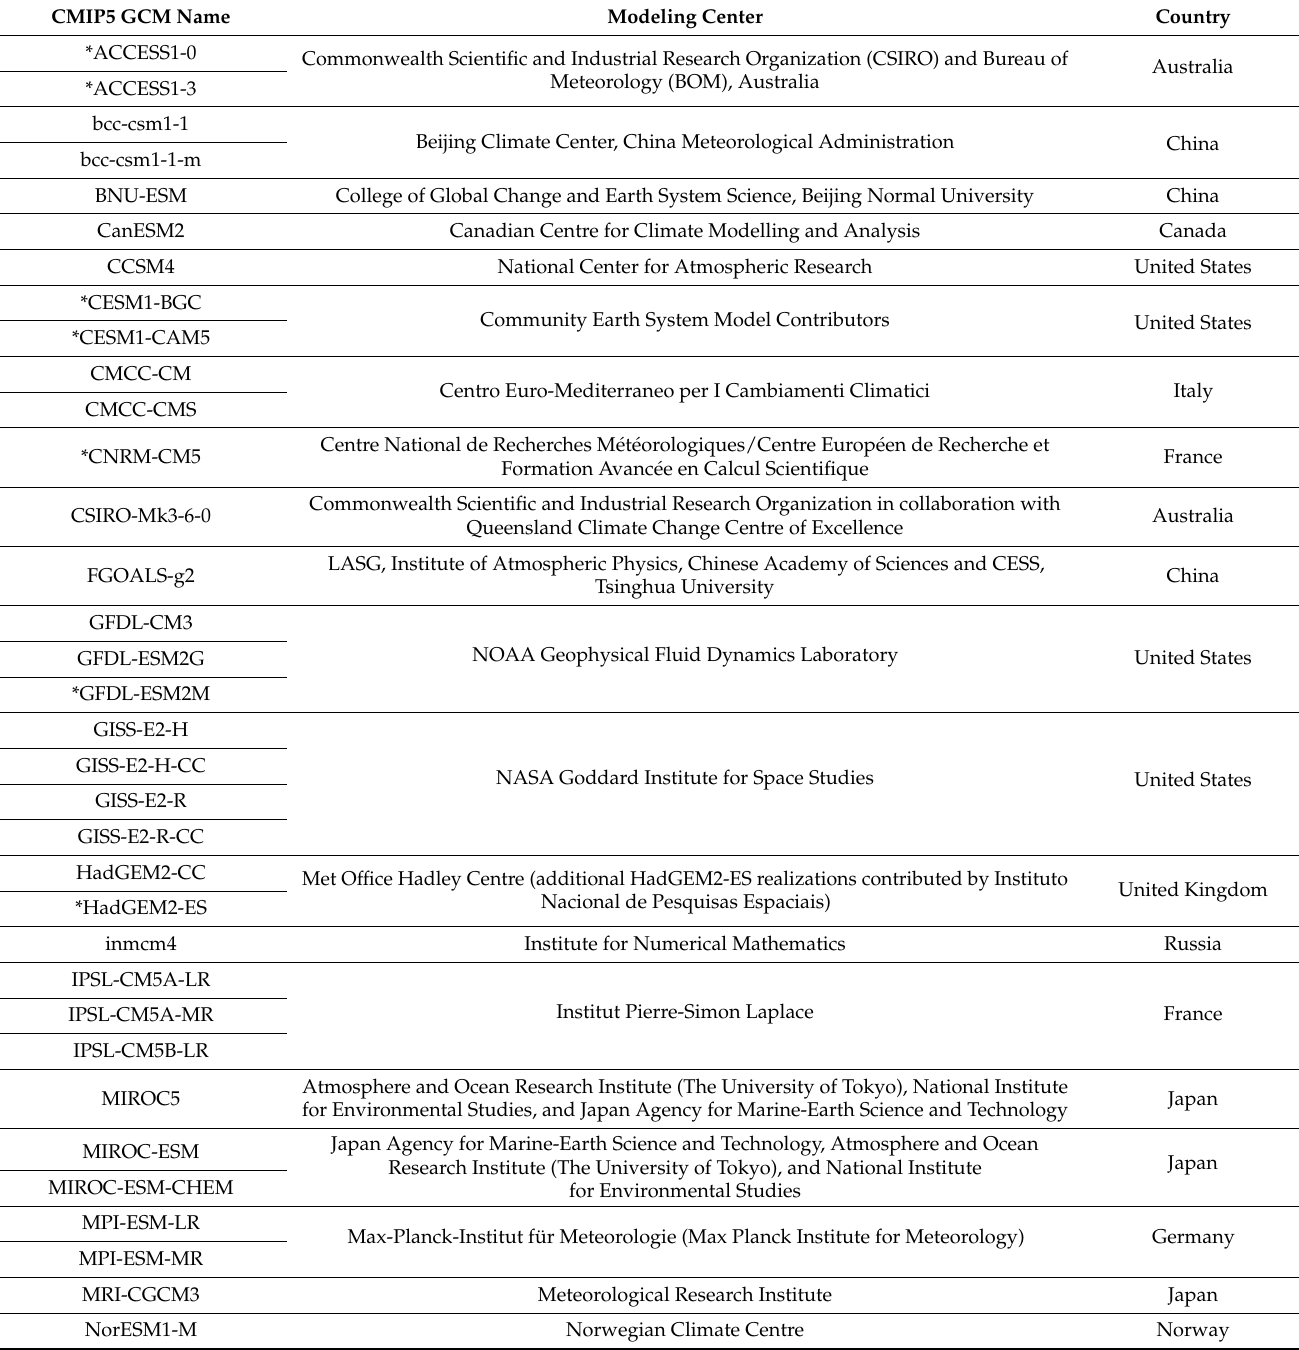
Table A2. The 34 Coupled Model Intercomparison Project 5 (CMIP5) global circulation models evaluated in this study (accessible through the Earth System Grid Federation CMIP5 archives https://esgf-node.llnl.gov/search/cmip5/ accessed on 1 February 2021) and their associated modeling center and country. Monthly resolution historical experiment model output was examined for three variables: precipitation (pr), minimum surface air temperature (tasmin), and maximum surface air temperature (tasmax). Only one realization (r1i1p1) was examined for each model. Orography (orog) and land fraction (sftlf) from each model was also used. Note: many more models exist in the CMIP5 archive, but we chose only those that provided data for all of the aforementioned variables as well as data for the historical, rcp 4.5, and rcp 8.5 experiments. NASA Earth Exchange 800m Downscaled Climate Projections dataset (NEX-DCP30) models that passed all of our performance metrics and were used in this analysis are indicated with an